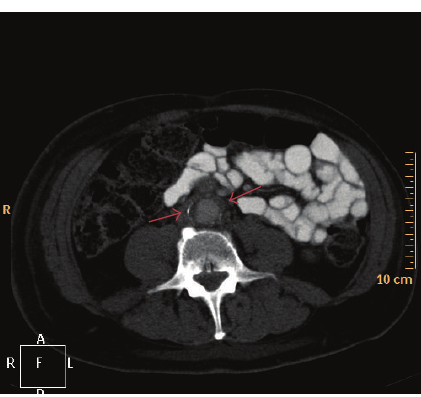
Figure 1: Abdominal CT scan illustrating fibrotic, possibly infiltra- tive changes around the abdominal aorta (red